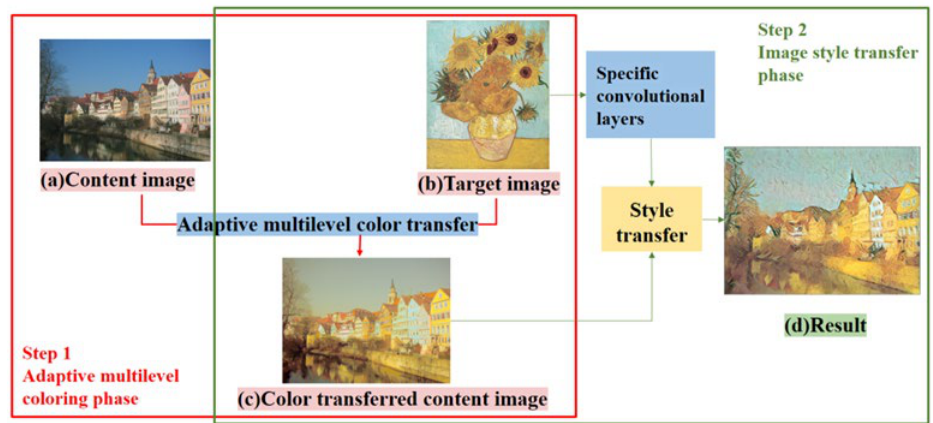
Figure 3. The architecture of image style transfer. Figure 3. Overview of the proposed framework.